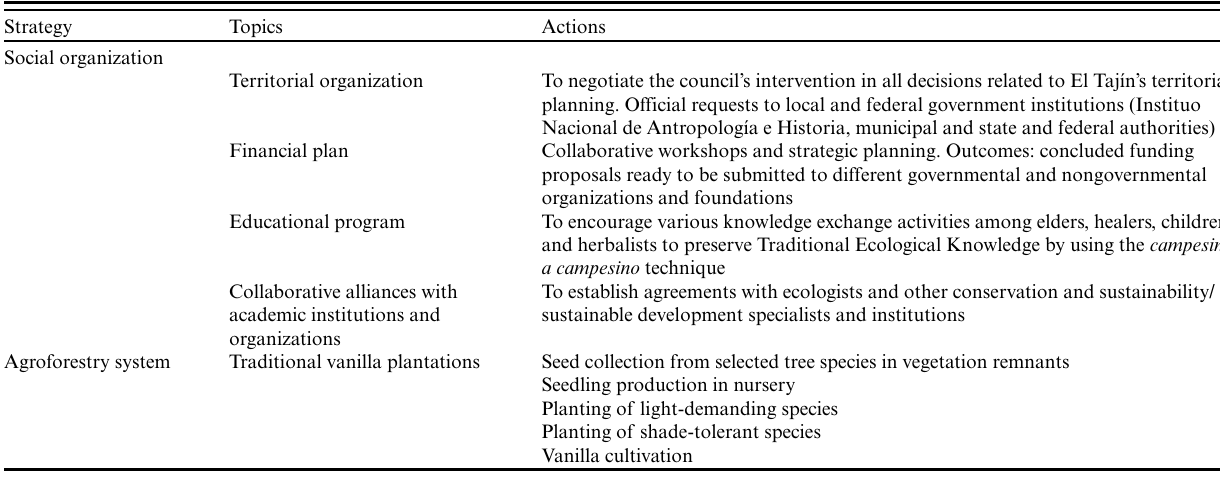
Table 2 . Strategic plan developed with the Voladores ’ council, to recover Zuelania guidonia populations in the El Tajín archaeological site (Papantla, Veracruz,